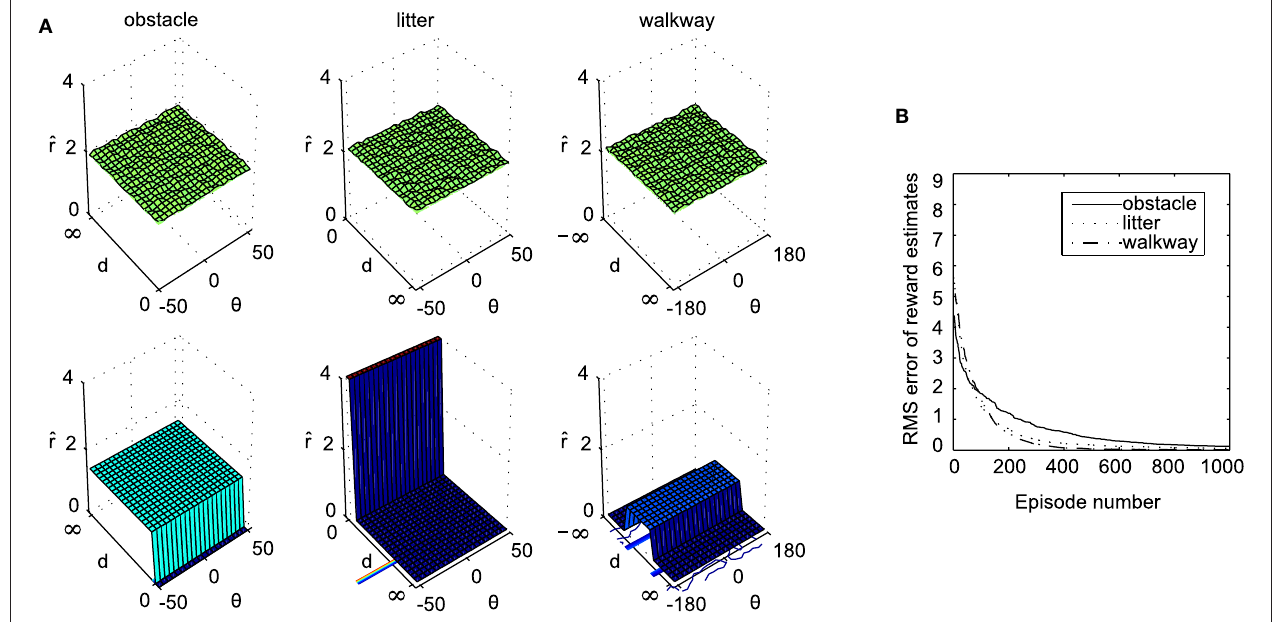
Figure 8 | reward calculations for the walkway navigation task for the three component behaviors using the credit assignment algorithm. (A) Top row: Initial estimates of the reward functions. Bottom row: Final reward estimates. (B) Time course of learning reward functions for each of the three component behaviors. RMS error between true and calculated reward as a function of iteration